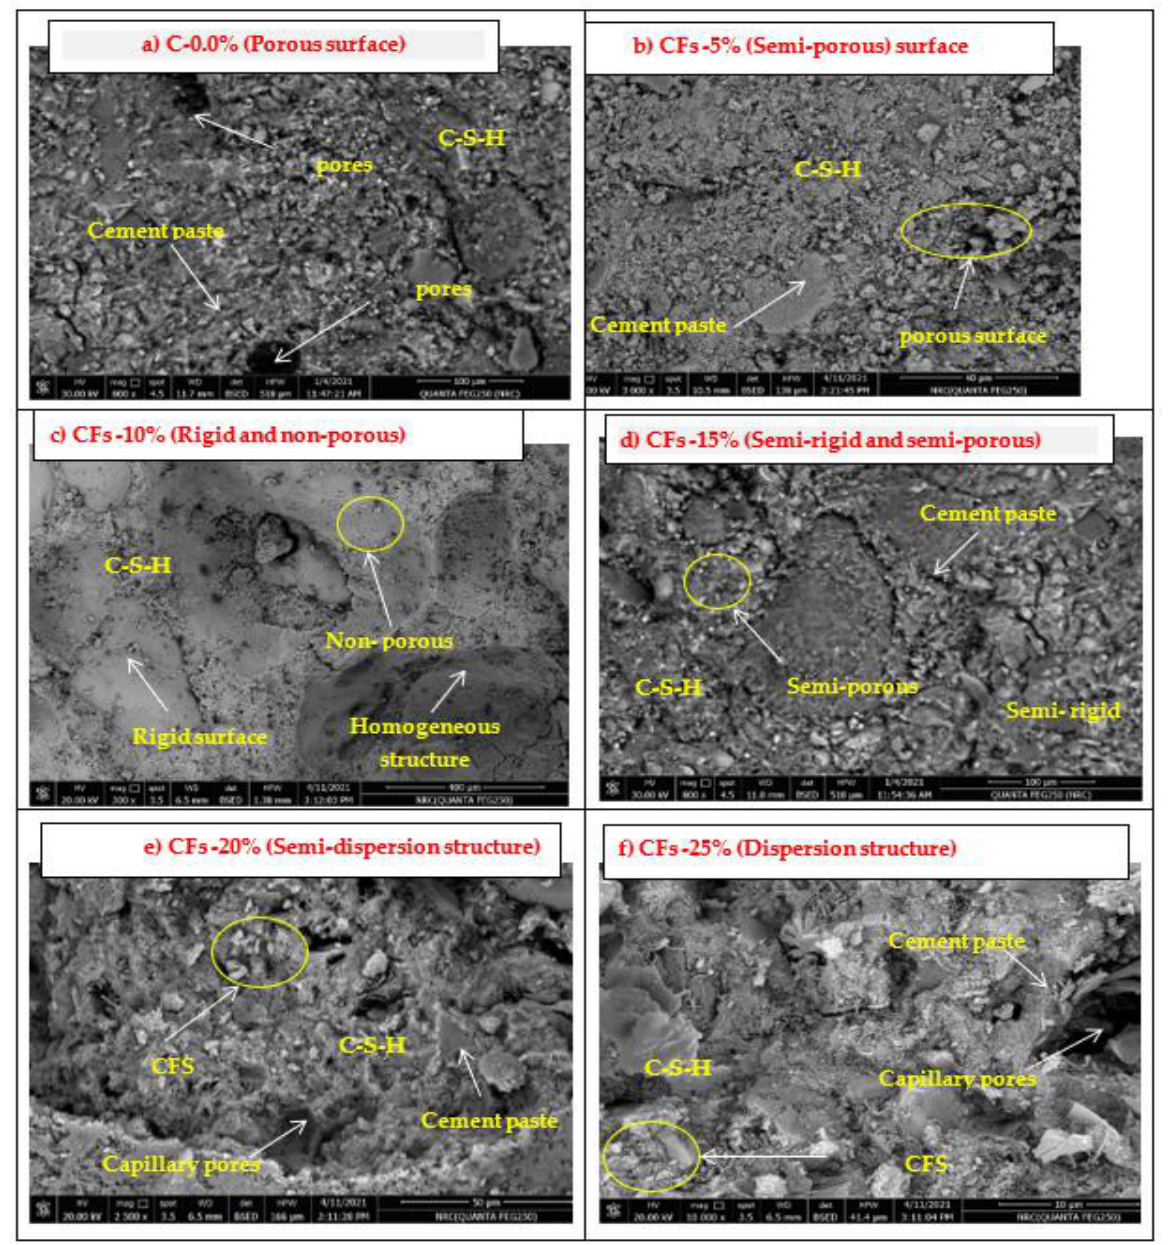
Figure 14. SEM micrographs of the samples: ( a ) C-0.0%, ( b ) CFS-5%, ( c ) CFS-10%, ( d ) CFS-15%, ( e ) CFS-20%, and ( f ) CFS - 25%.